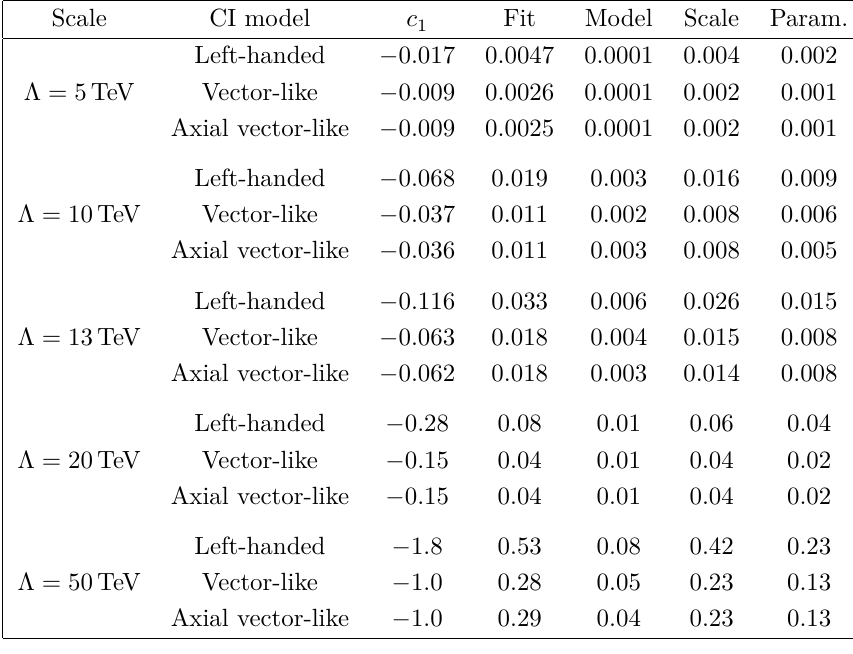
for various scales Λ . The 1